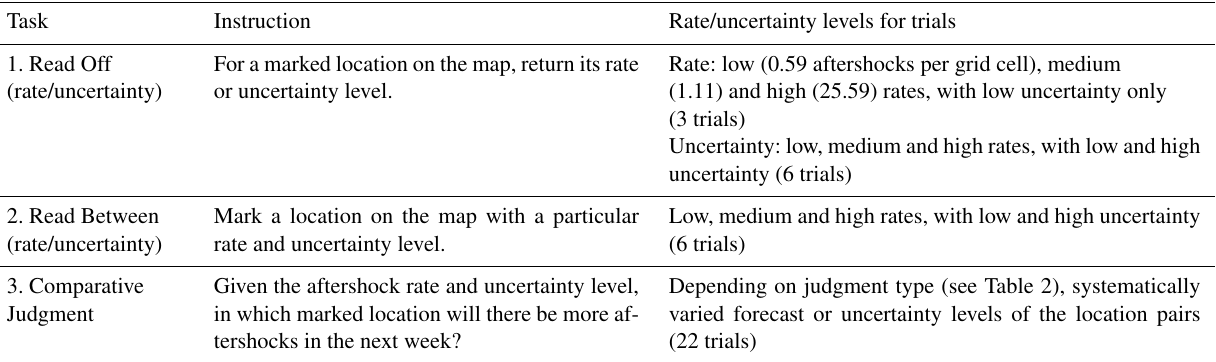
Figure 2. Adjacent uncertainty visualization: map of most likely forecasted aftershock rates (a) next to a map of its model uncertainty (b) . Figures 2–4 show UVs for one of the two forecast regions. In the experiment, the color palette for the right map (showing certainty rather than uncertainty) proceeded from light to dark for areas of lower to higher certainty, matching the color direction of the rate map. (See experiment screenshots in Figs. S2–S4.) Table 1. Tasks to evaluate effects of UVs on map reading (tasks 1 and 2 for research question 1) and judgment (task 3 for research question 2) with aftershock forecast maps.